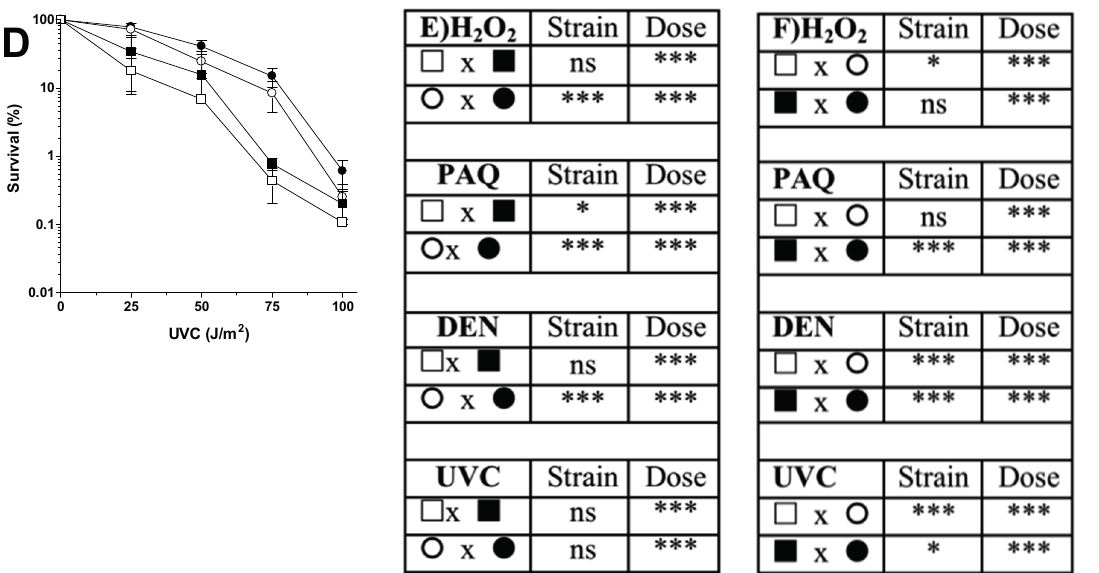
Figure 4. Sensitivity of stationary phase (STAT) cultures of yeast transformants after exposure to ( A ) H 2 O 2 ; ( B ) Paraquat (PAQ); ( C ) DEN; and ( D ) UVC. Symbol legend: □ = WT(pRS313); ■ = WT(pLBF01); ○ = Sc sod2 Δ (pRS313); ● = Sc sod2 Δ